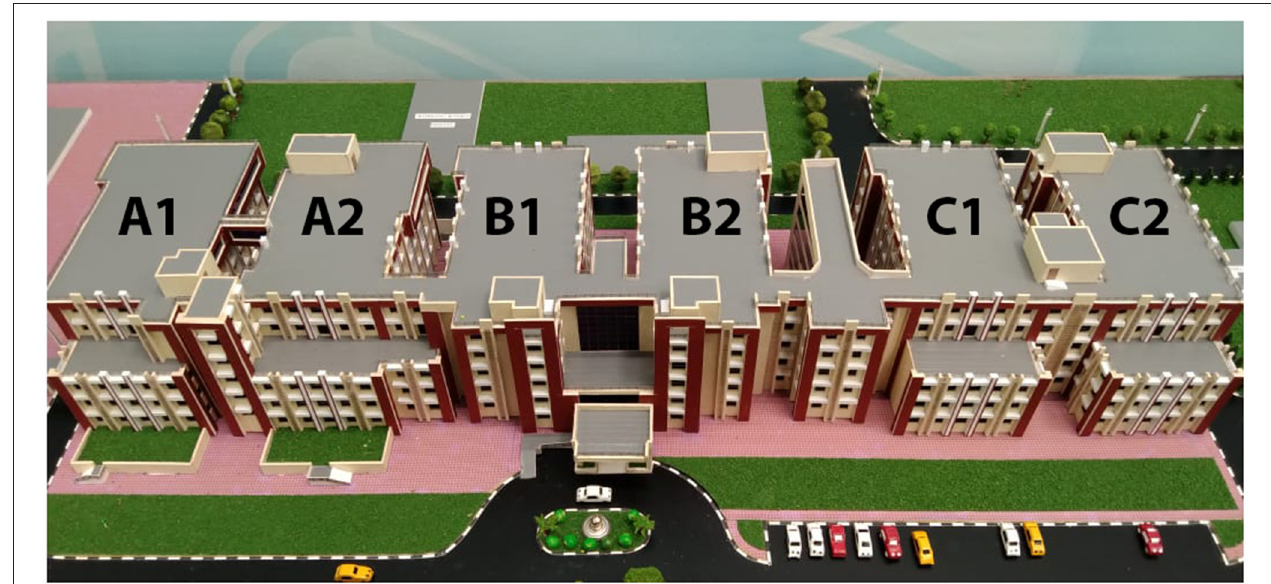
FIGURE 1 | A model of the hospital transformed to function as COVID-19 facility. The design resembles a comb with the corridor representing the shaft and the blocks representing the comb’s teeth. There are five levels and a